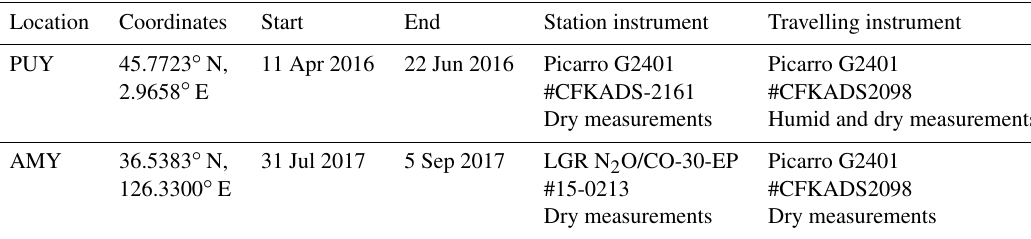
Table 3. Overview of ambient-air CO comparison campaigns.